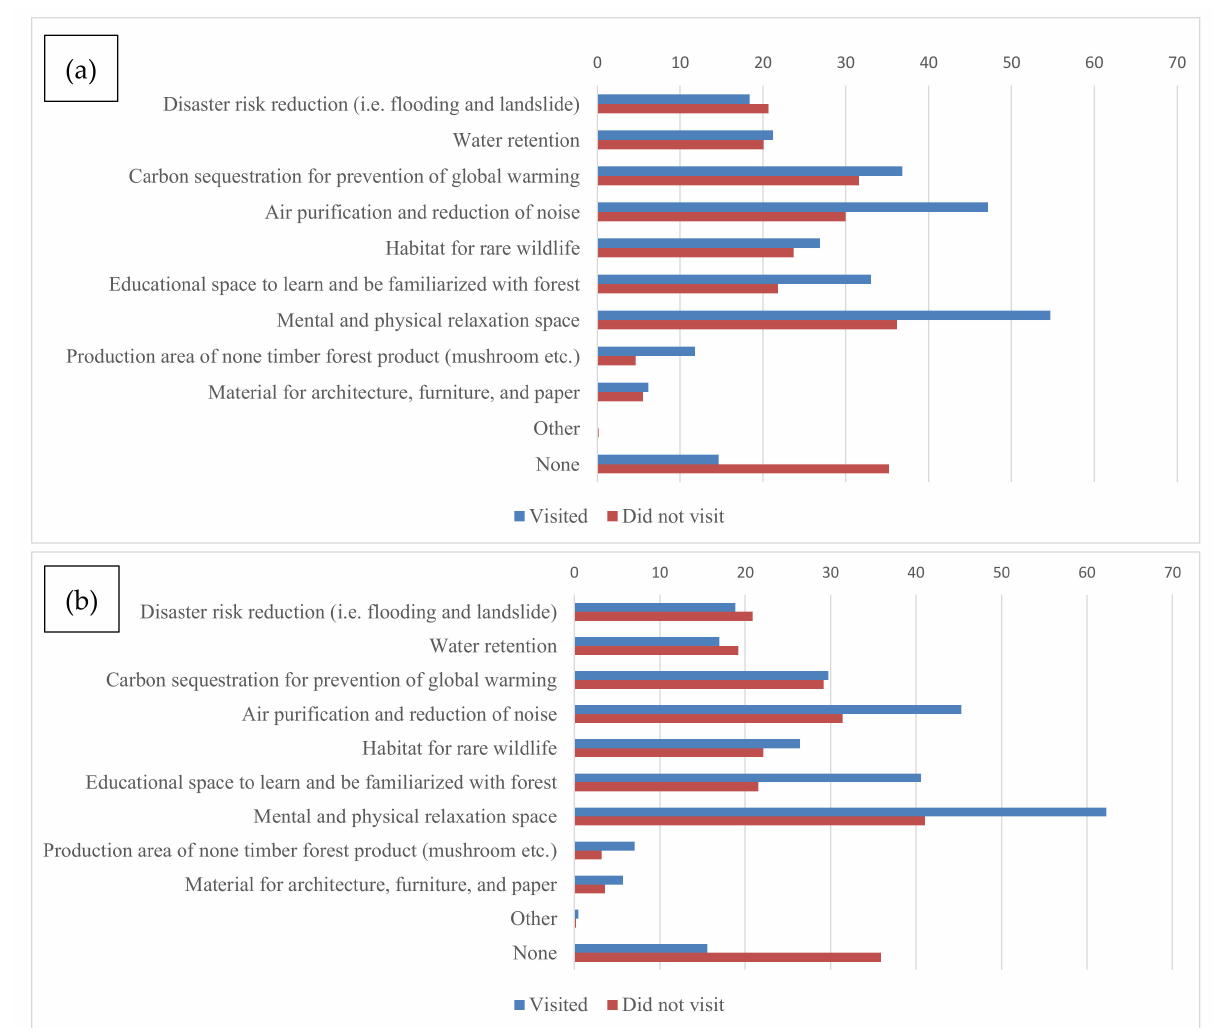
Figure 6. Awareness of the functions of forestlands and mountain areas (Respondents were asked about their awareness ( a ) before and ( b ) after the emergency